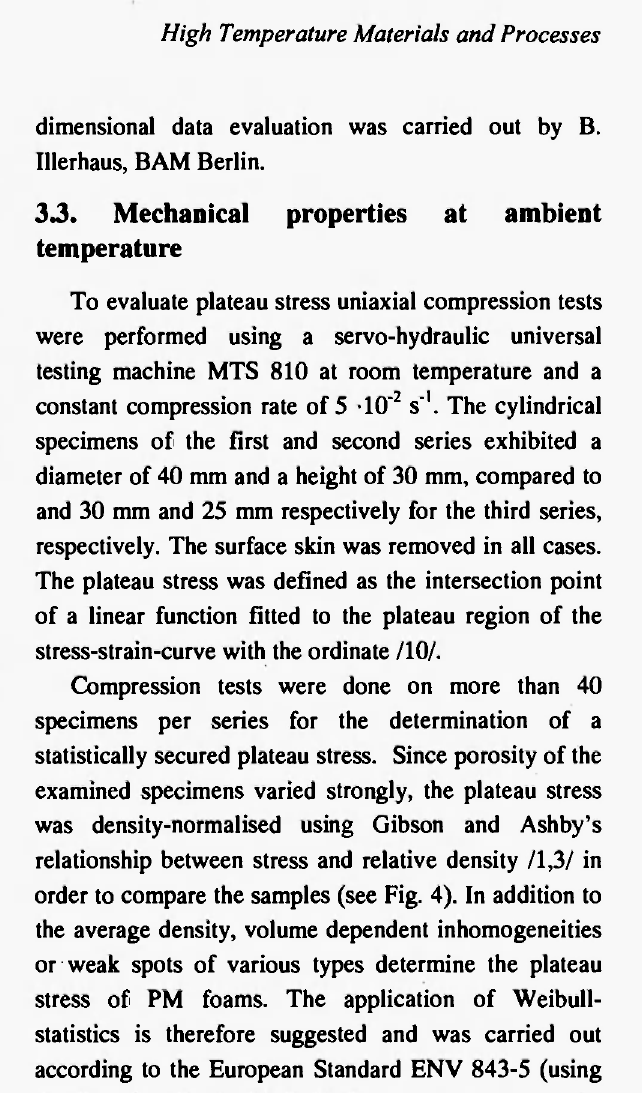
Fig. 3: Varied contact distribution function of samples of test series 3 (modified cast alloy AlSi7), after U. Mosler et al. /15/